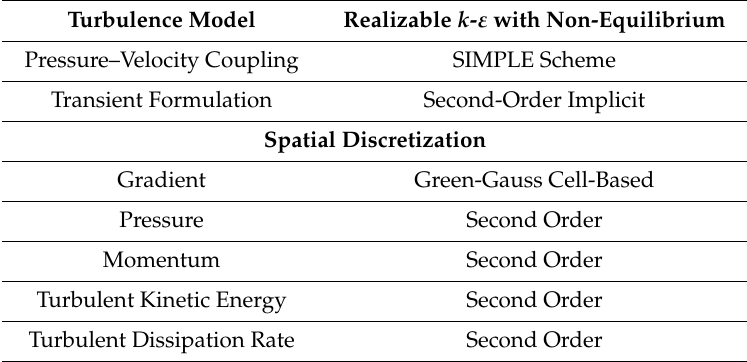
Table 2. Simulation parameters.